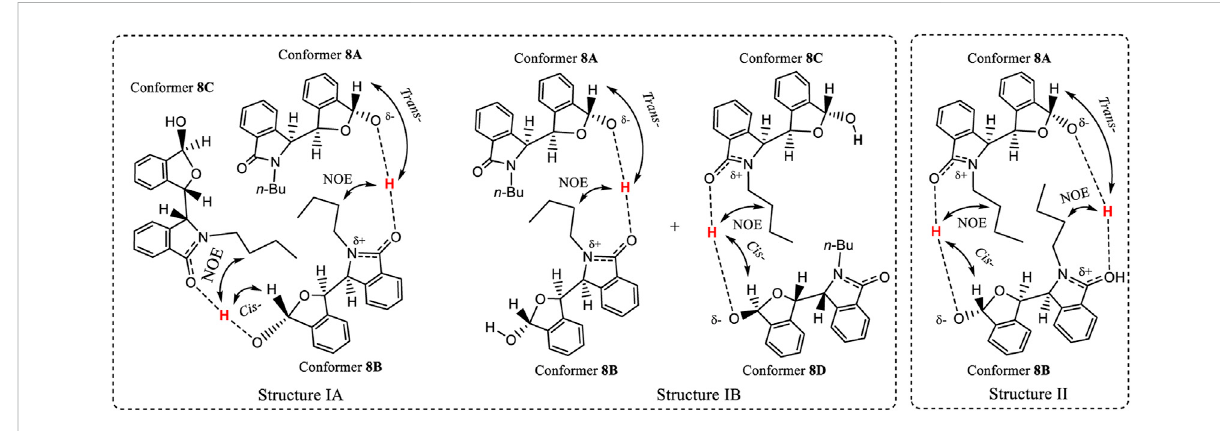
FIGURE 10 Twohypotheticalaggregationstatestructuresof 8 inCDCl 3 solution,wheretheO-Hmayelongateandtheprotonapproachesclosetoanother molecule ’ s > C=O within the aggregate. After comprehensive consideration, the favourite dimeric structure is IB where conformers 8A and 8B are